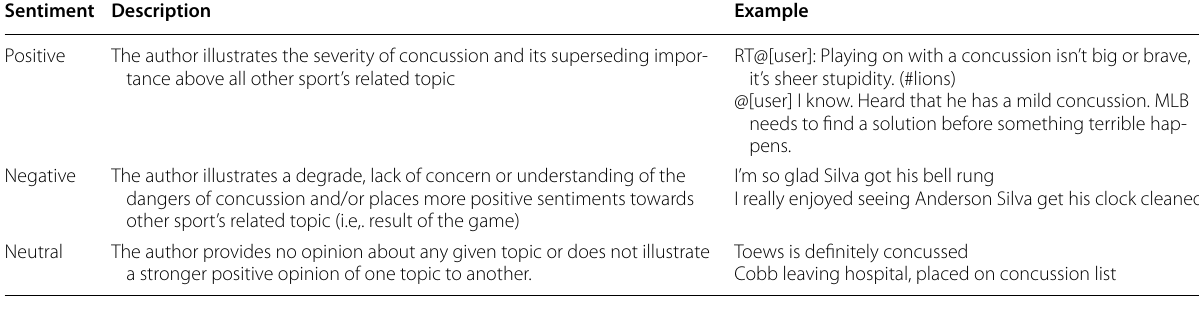
Table 2 Description of Sentiment labels of Concussion Dataset